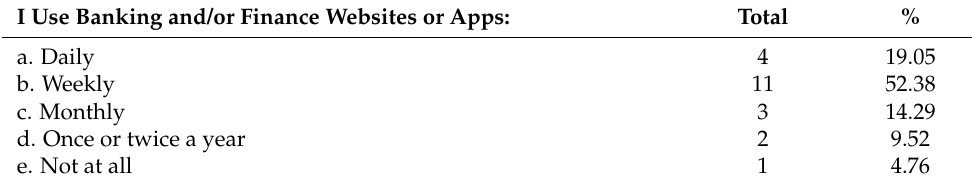
Table 1. Frequency of usage of banking/finance